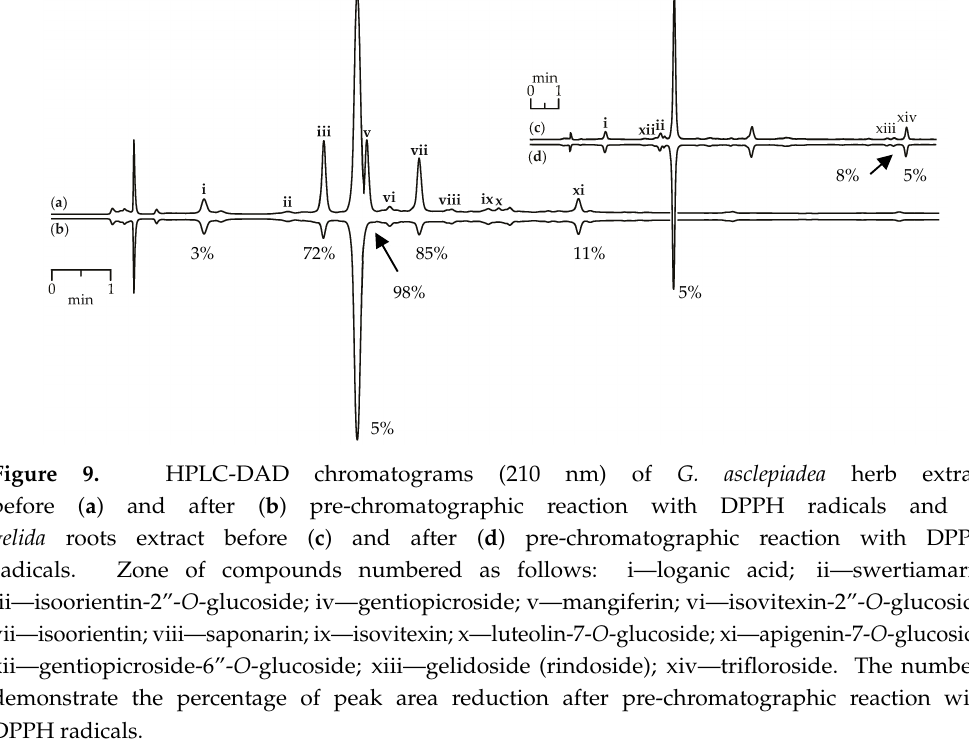
Figure 9. HPLC-DAD chromatograms (210 nm) of G. asclepiadea herb extract before ( a ) and after ( b ) pre-chromatographic reaction with DPPH radicals and G. gelida roots extract before ( c ) and after ( d ) pre-chromatographic reaction with DPPH radicals. Zone of compounds numbered as follows: